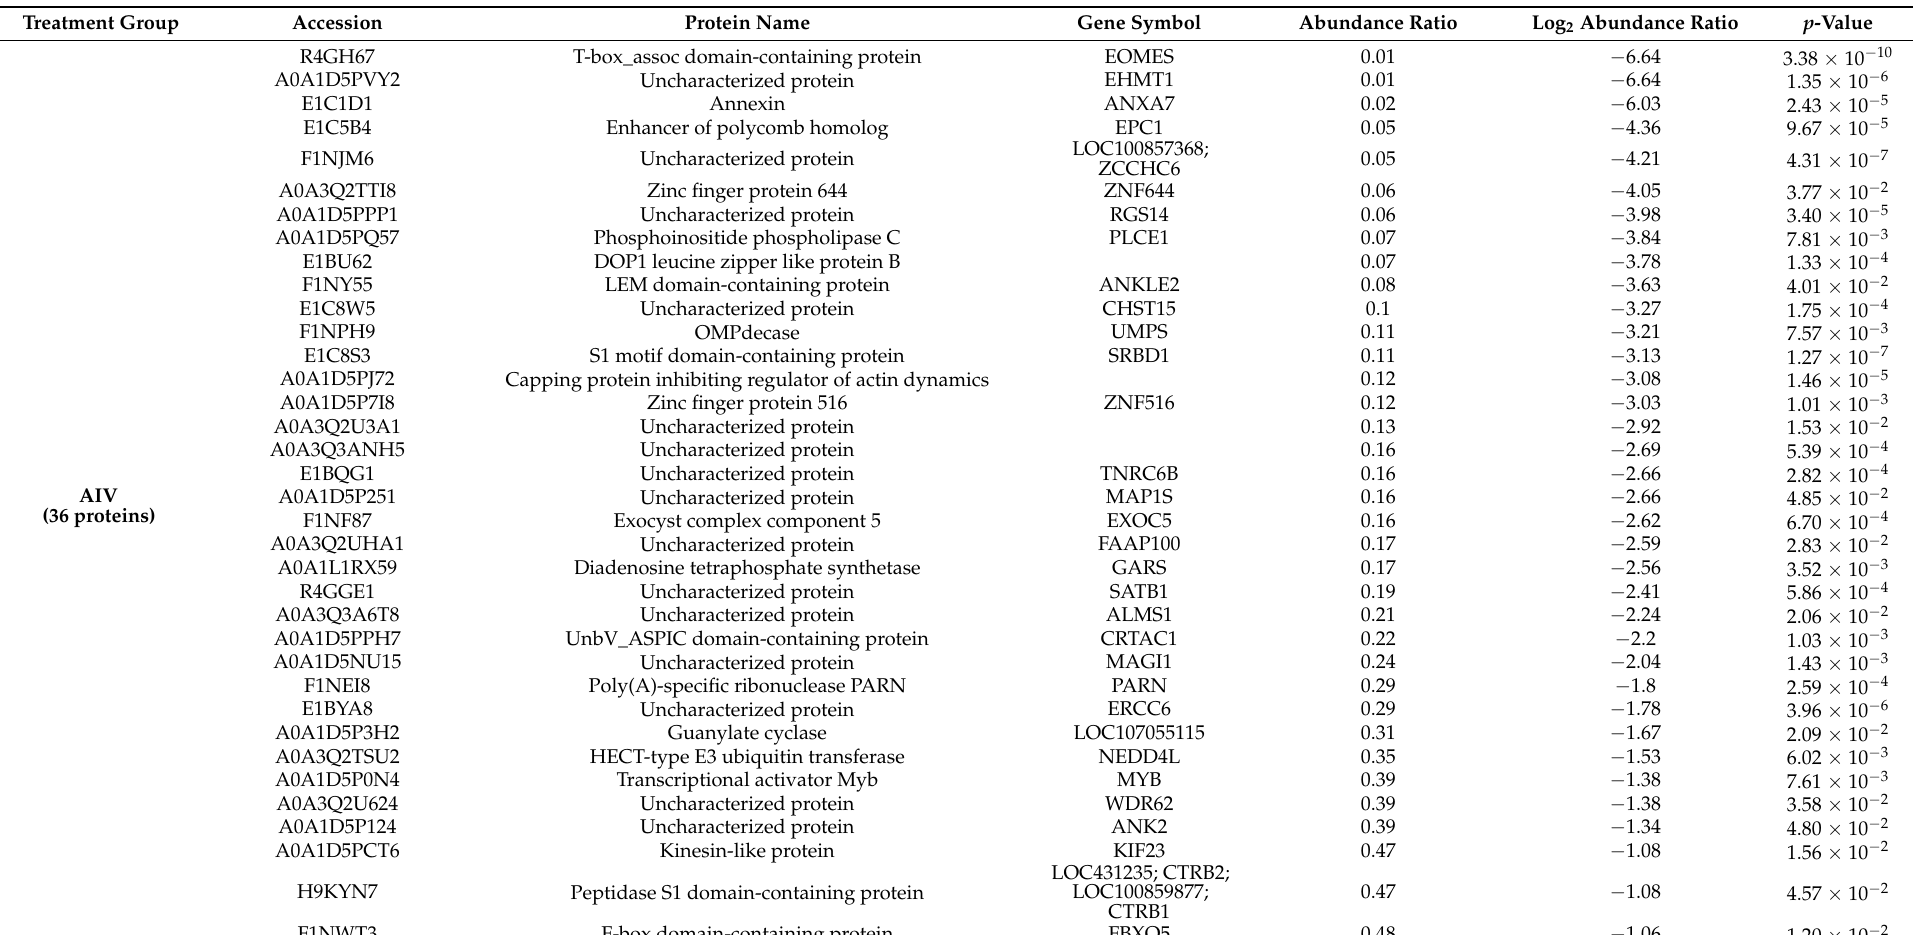
Table 3. Down-regulated proteins of EVs from TOCs treated with AIV, LPS, and polyI:C. Following differential expression filtering (abundance ratio ≥ 2-fold change and p -value < 0.05), 36, 54, and 52 proteins were found to be down-regulated in the AIV, LPS, and polyI:C treatment groups,